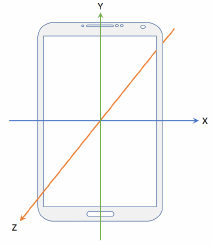
Figure 7. Accelerometer axes on the mobile phone.